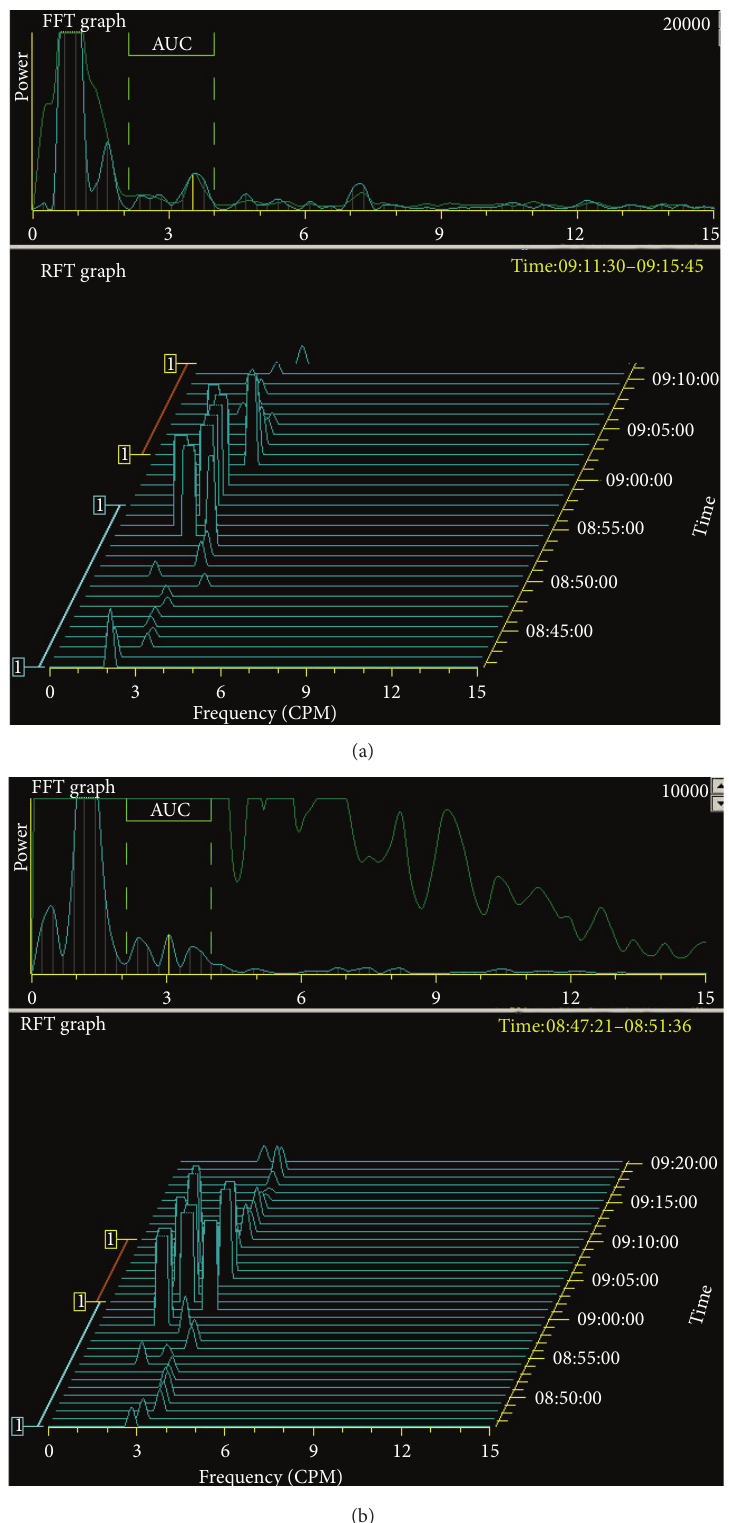
Figure 16: Electrogastrography. Severe gastric arrhytmia (running spectral analysis based on Fourier